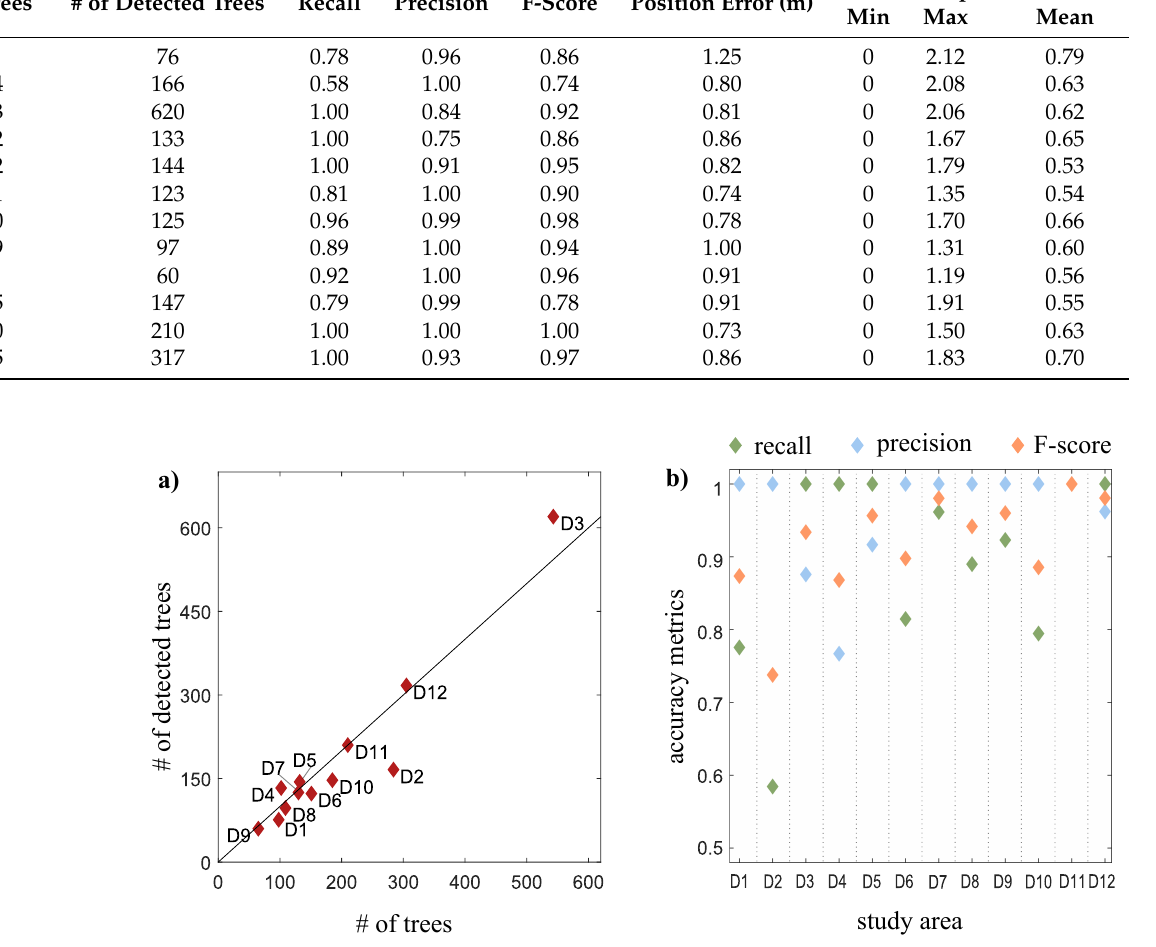
Figure 7. ( a ) count of the actual trees (# of trees) versus the count provided by the algorithm (# of detected trees) for the sites D 1– D 12 (red diamonds). The black line represents a perfect match. ( b ) accuracy metrics, where green, blue, and orange indicate recall, precision, and F-score metrics,